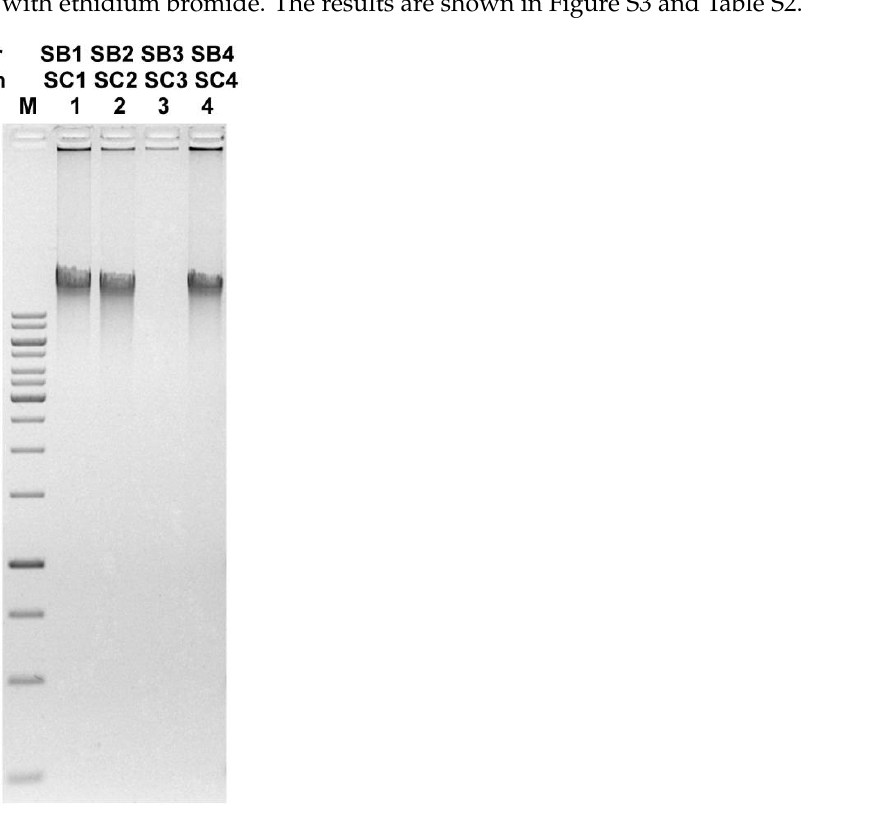
Table 1. DNA concentration and purity determined by spectrophotometric analysis, using commer- cially available DNA purification kits.